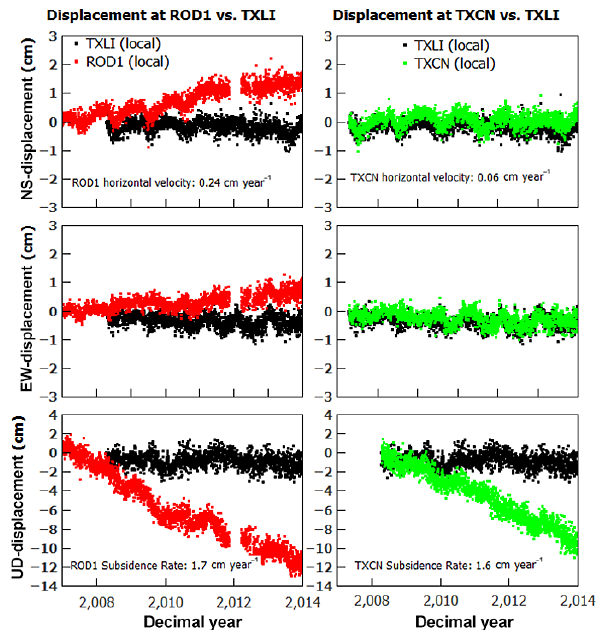
Figure 5. Displacement time series of two rapidly subsiding CGPS sites (ROD1 and TXCN) in northern Houston. The displacement time series of a stable site (TXLI) are plotted for comparative pur- poses. Locations of these three stations are plotted in Fig. 6. The reference frame is SGOMRF.